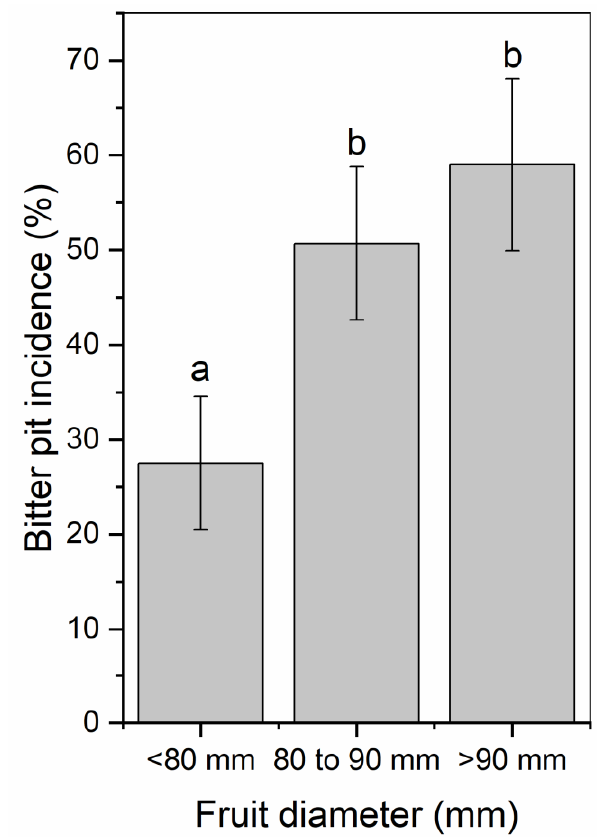
Figure 9. Percentage of total Honeycrisp fruit with bitter pit for fruit that was less than 80 mm, 80 to 90 mm, or greater than 90 mm in diameter after three months of storage in regular atmosphere at 1 ◦ C. Letters denote significant differences between each size category determined using a Fisher’s LSD test (α = 0.05).